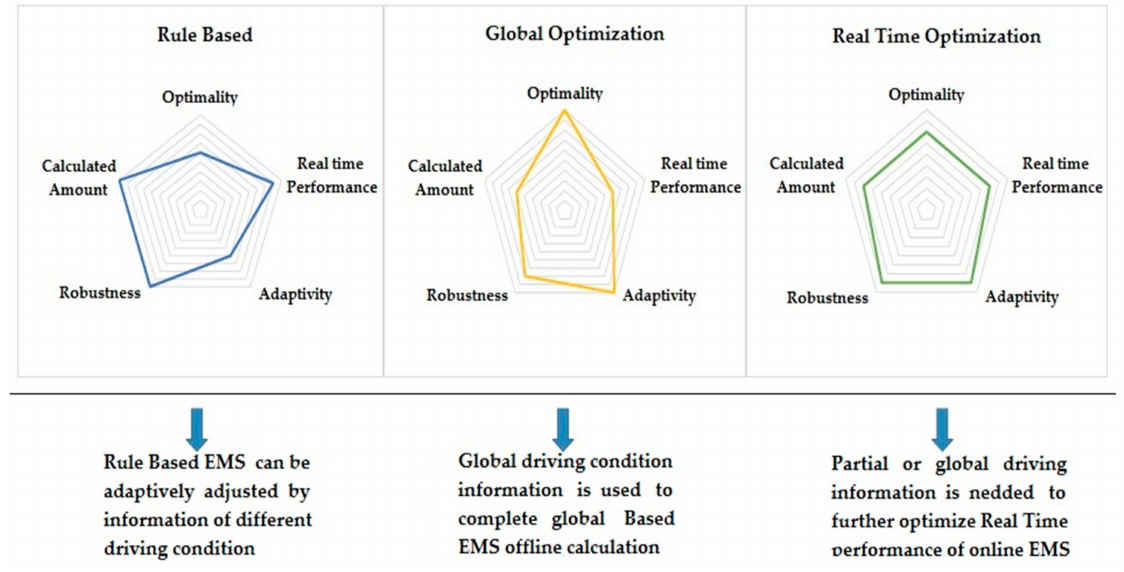
Figure 7. The benefits of driving information prediction for energy management systems optimization